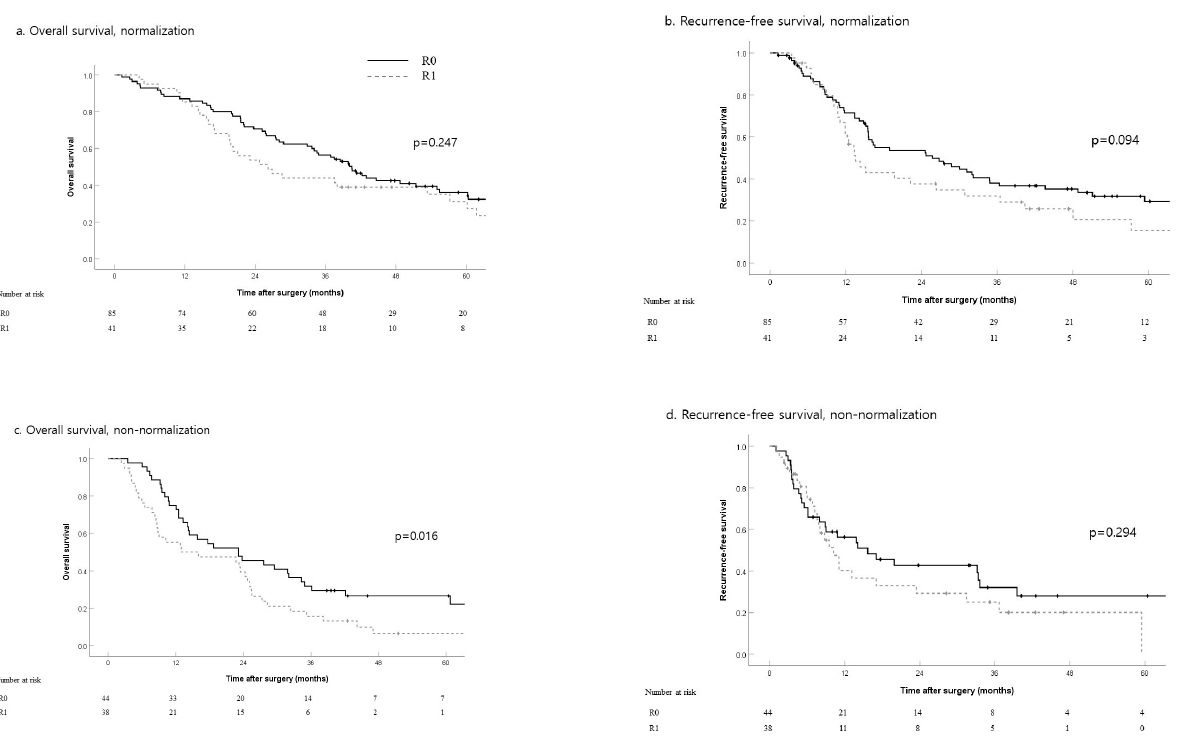
Figure 4. Overall survival and recurrence-free survival by resection margin status in patients with elevated CA19-9 level that normalized ( a , b ) and did not ( c , d ) normalize after surgery. ( a ) Overall survival, normalization; ( b ) recurrence-free survival, normalization; ( c ) overall survival, non-normalization; ( d ) recurrence-free survival, non-normalization.